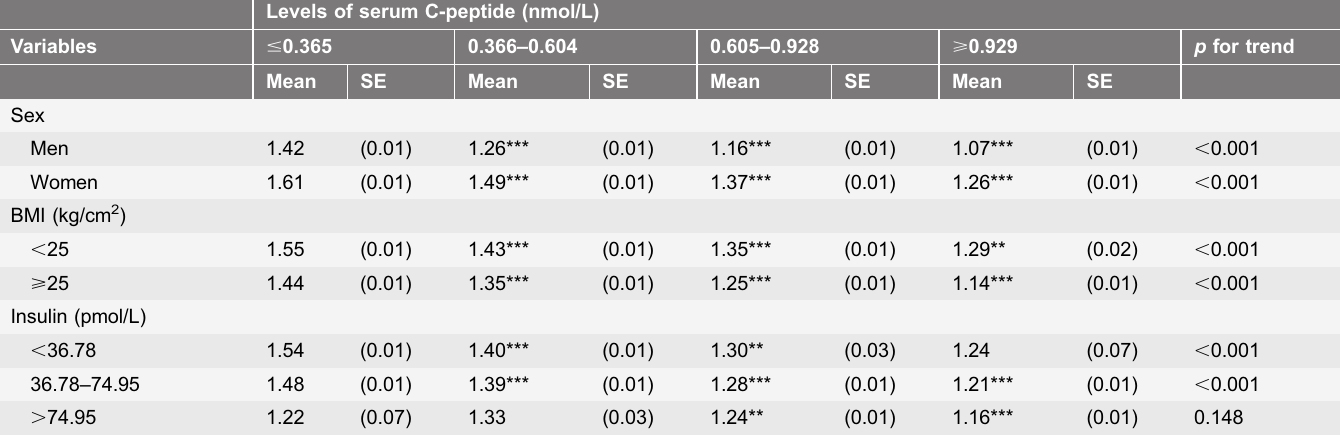
Table 2. The mean and standard error for serum HDL-C levels in different quartiles of serum C-peptide levels by analysis of covariance. Levels of serum C-peptide (nmol/L)